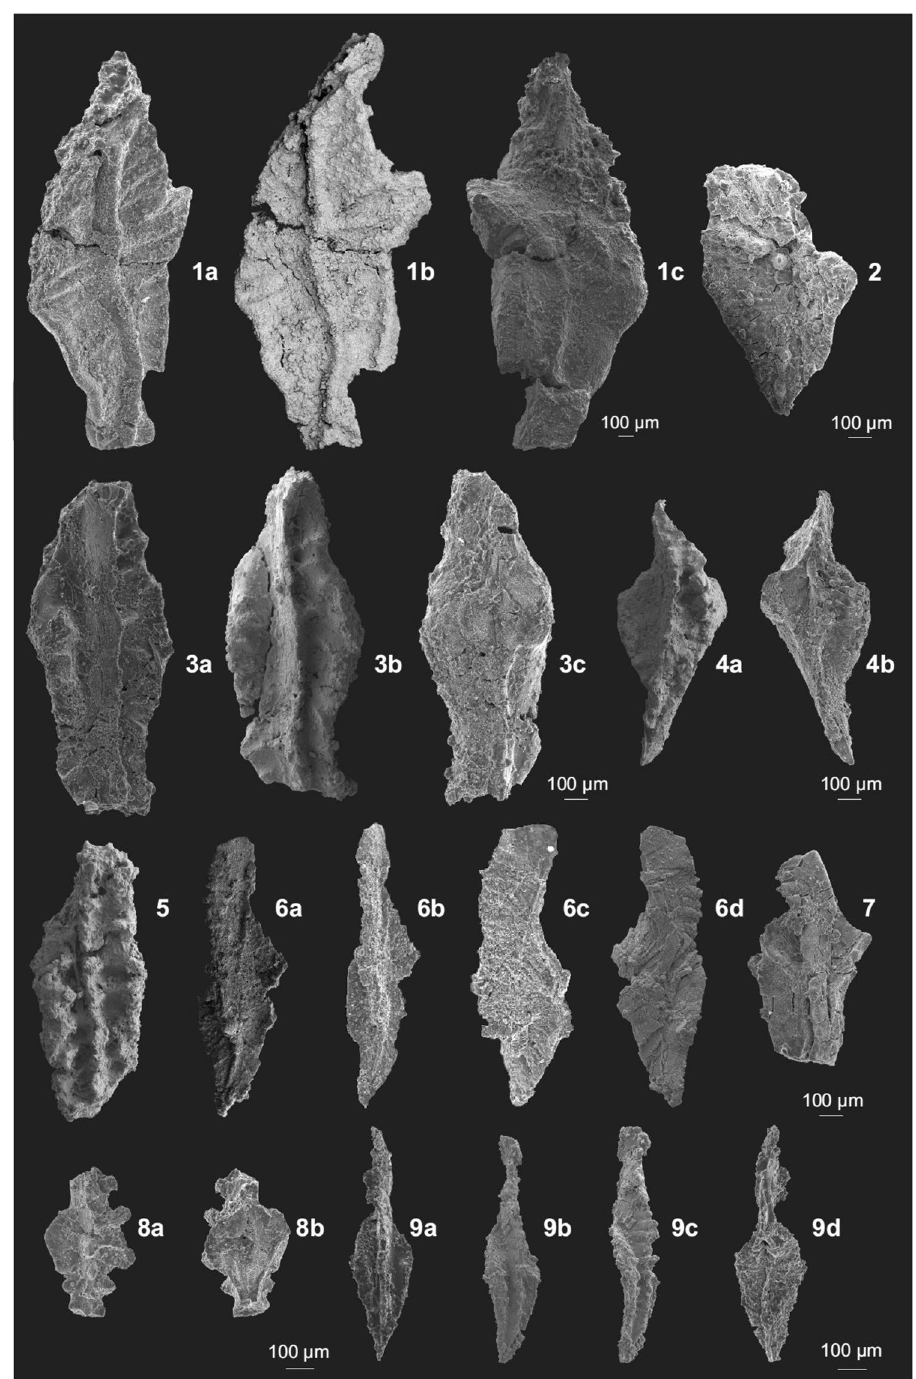
Figure 5. Conodonts from the Novchomok Section 1. Pseudopolygnathus sp. (1a. oblique, 1b. upper, 1c. lower views, sample 019, MUZ PIG 1825.II.11), 2. Polygnathus aff. Po . styriacus Ziegler (upper view, sample 09A, MUZ PIG 1825.II.12), 3. Pseudopolygnathus sp. (3a. upper, 3b. oblique, 3c. lower views, sample 019, MUZ PIG 1825.II.13), 4. Pseudopolygnathus controversus Morphotype 1 Sandberg and Ziegler (4a. upper, 4b. lower views, sample 019, MUZ PIG 1825.II.1), 5. Pseudopolygnathus aff. Ps . primus Branson and Mehl (5. upper view, sample 019, MUZ PIG 1825.II.14), 6. Palmatolepis sp. (6a. upper/oblique, 6b. upper, 6c. lateral, 6d. lower views, sample 09A, MUZ PIG 1825.II.15), 7. Polygnathus vogesi Ziegler (7. upper view, sample 01, MUZ PIG 1825.II.16), 8. Bispathodus cf. B . aculeatus aculeatus (Branson and Mehl) (8a. upper, 8b. lower views, sample 09A, MUZ PIG 1825.II. 2), 9. Polygnathus communis dentatus Druce (9a. upper, 9b. oblique, 9c. lateral, 9d. lower views, sample 019, MUZ PIG